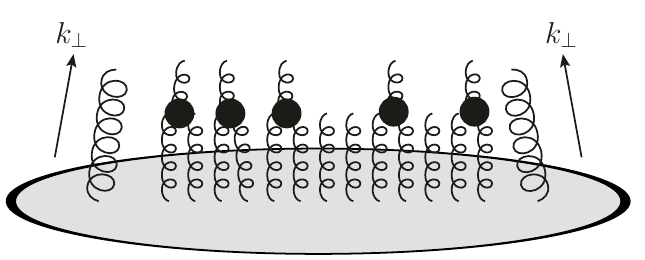
Figure 5 . Saturation effects from the evolution: the non-linearities in the evolution equation account for recombination effects in the target.